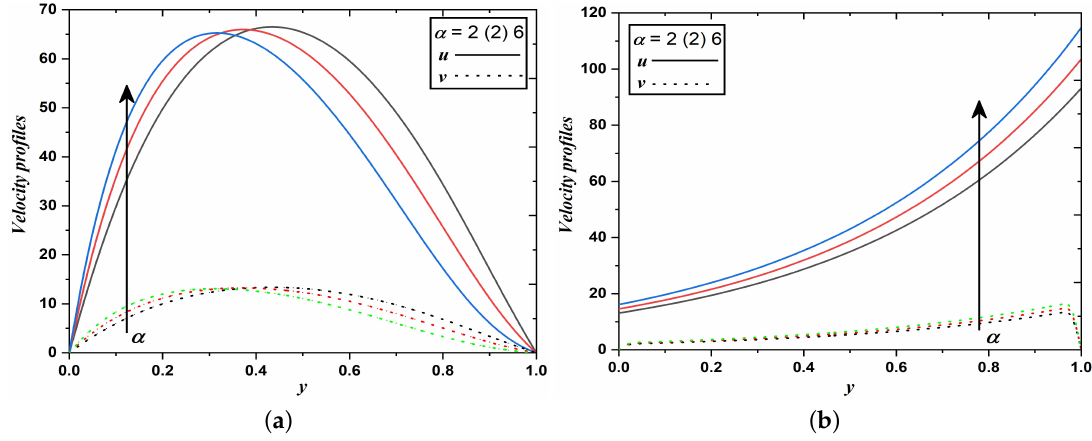
Figure 2. Velocity profiles when stratification decay parameter varies (Case 1 & 2).